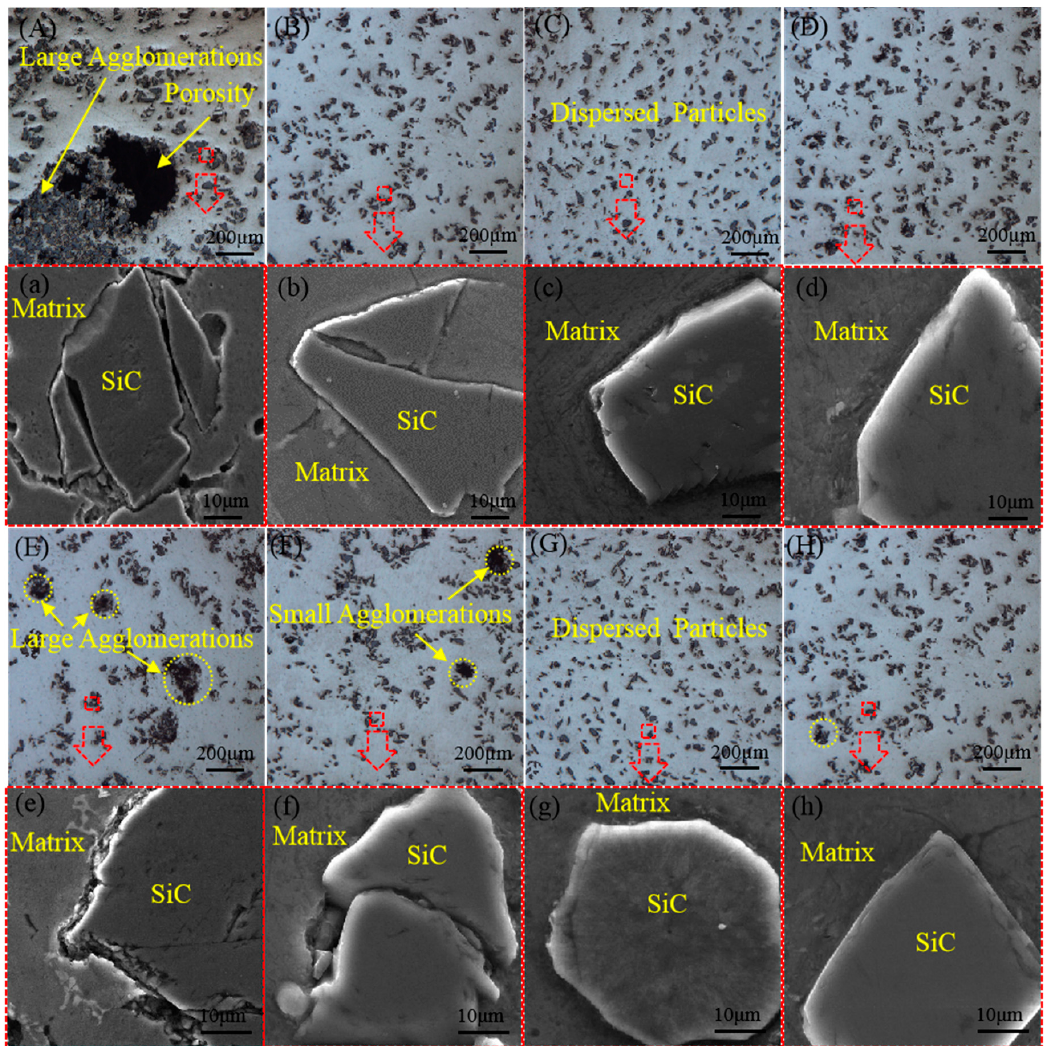
Figure 4. Effect of ultrasonic treatment time on optical morphology of SiCp/7085 composites under certain amplitude of 12 µ m: panels ( A – D ) show the distribution of particles and panels ( a – d ) show the interface of composite in the 20mm thickness of the ingot after 0min, 5 min, 10 min, and 15 min; panels ( E – H ) show the distribution of particles and panels ( e – h ) show the interface of composite in the 50 mm thickness of the ingot after 0 min, 5 min, 10 min, and 15 min.